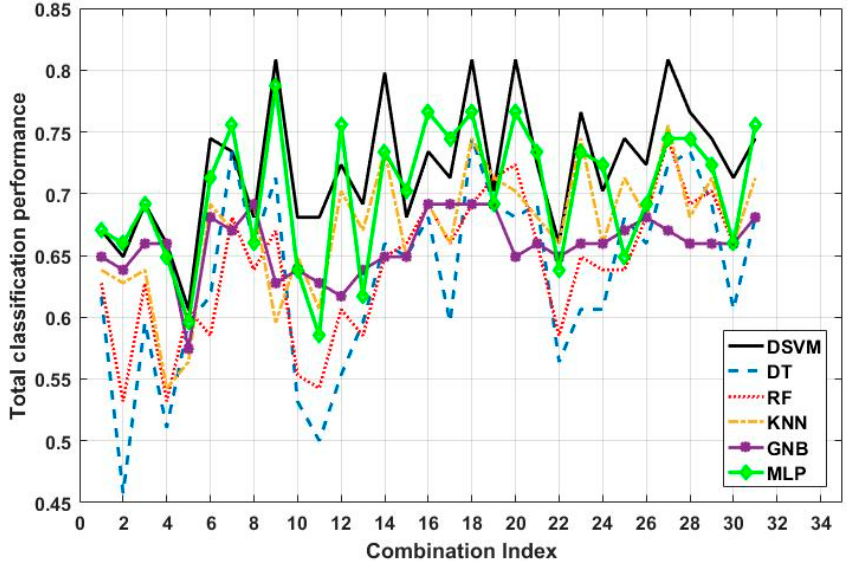
Figure 11. Total classification accuracy versus combination index for classifying wood and plastic for different classification approaches using SKF cross-validation. Table 5. DSVM classification performance for classifying cardboard vs. the rest using LOO cross-validation.